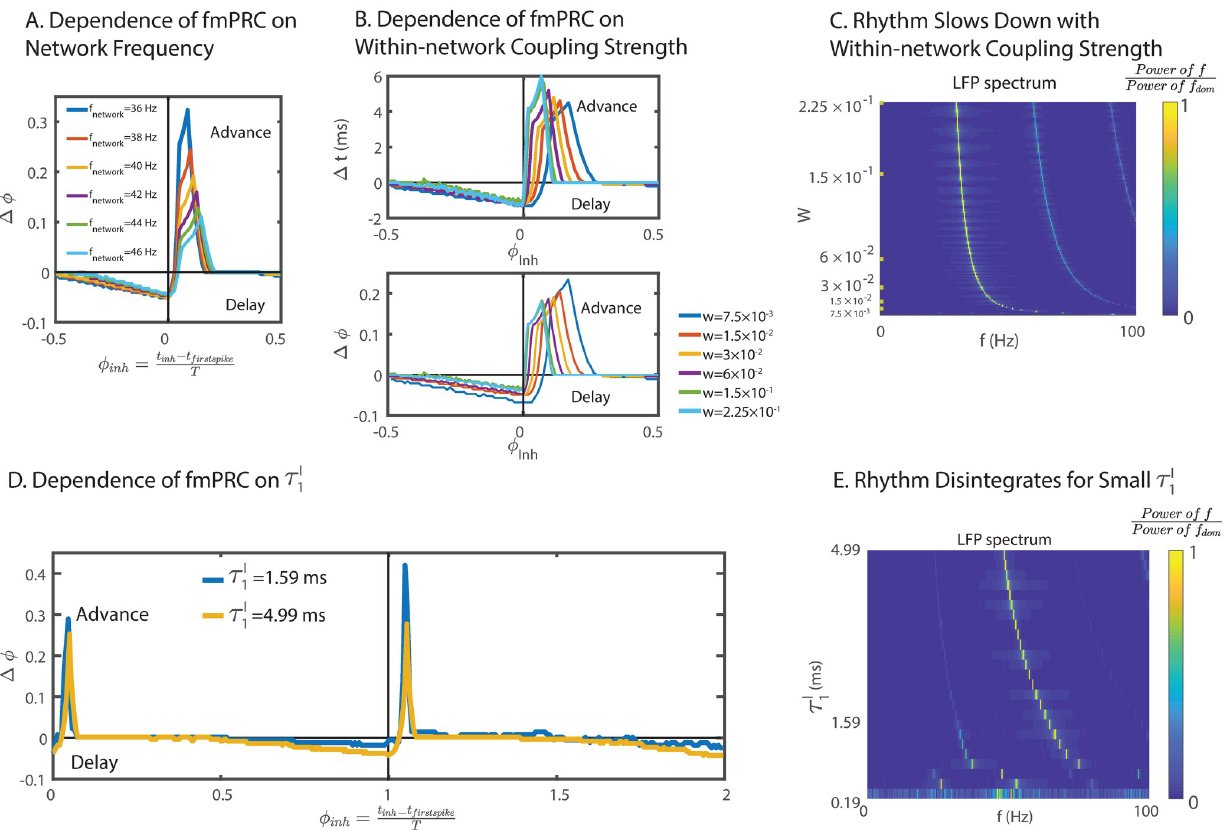
Fig 3. The paradoxical phase response of a heterogeneous ING network is robust. (A) The phase advance of the fmPRC decreased with the natural frequency ( CV ( I ) = 0.15). (B) The fmPRC did not depend sensitively on the within-network coupling strength W ( CV ( I ) = 0.15, I ( I ) = 10.8 pA). Top: the temporal advance increased with within-network coupling strength. Bottom: the phase advance decreased with within-network coupling strength. (C) The Fourier spectrum of the LFP as a function of the within-network coupling strength W . Parameters as in (B). (D) Paradoxical phase response in the absence of an explicit delay, τ d = 0, for different synaptic rise times t I ( CV ( I ) = 0.05, I ( I ) = 15.84 pA). For low t I (blue curve), the PRC alternated in subsequent cycles 1 1 reflecting the subharmonic nature of the rhythm, but it still showed a strong paradoxical component. (E) The Fourier spectrum of the LFP as a function of the synaptic time constant of rise t I . With decreasing t I , a subharmonic peak emerged and eventually the rhythm disintegrated. Parameters as in D. In (A), 1 1 (B) and (D), perturbations were made with a square-wave inhibitory current pulse with duration 0.1 ms to each neuron. In (A) and (B), the amplitude of the current was 1600 pA, resulting in a 2 mV rapid hyperpolarization. In (D), the amplitude of the current was 400 pA, resulting in a 0.5 mV rapid hyperpolarization.